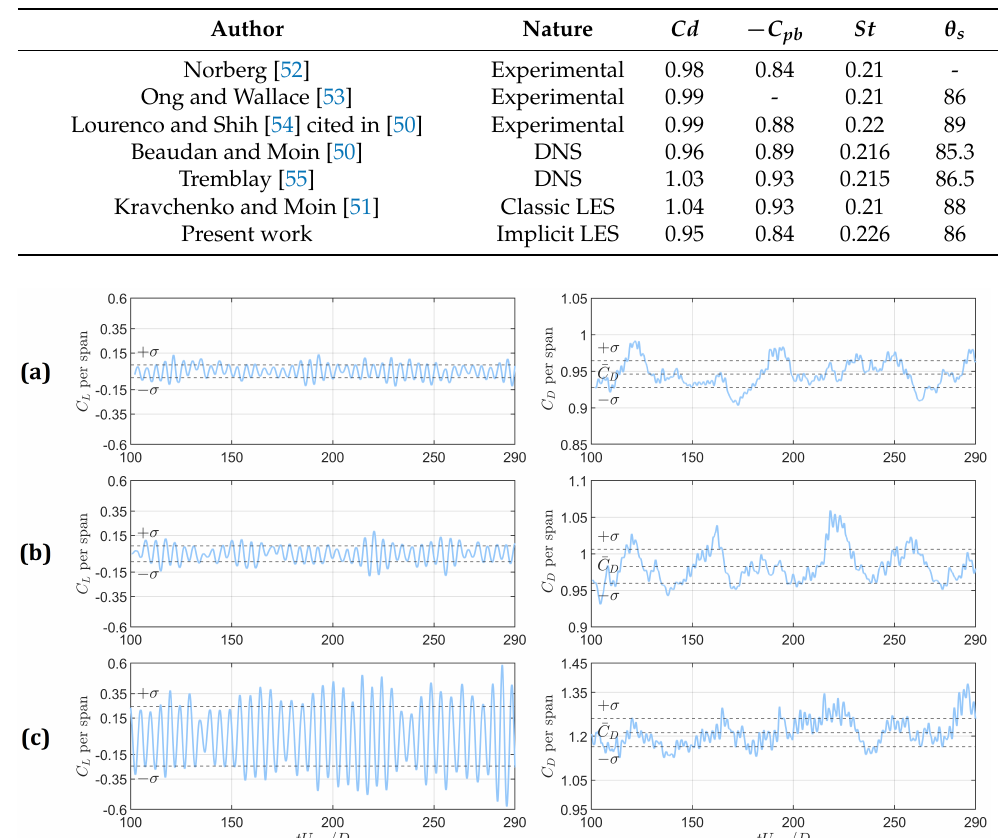
Table 4. Comparison and validation of results for the straight cylinder at Reynolds 3900.